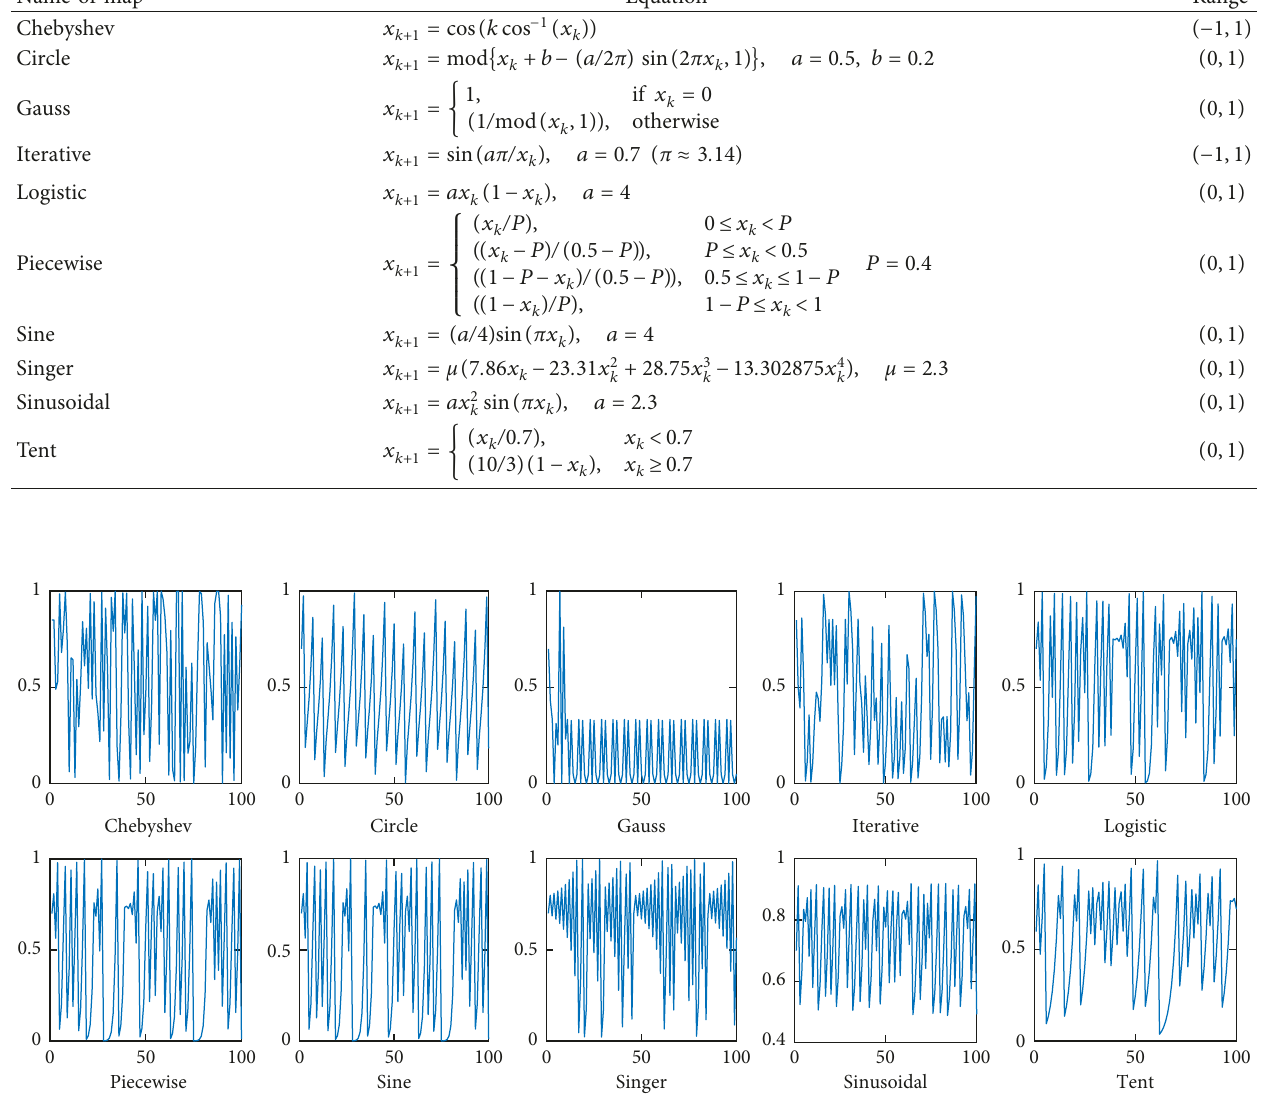
Figure 1: Chaotic